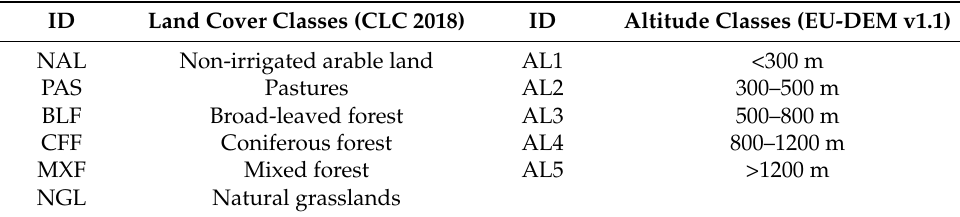
Table 2. Land cover (CLC 2018) and elevation (EU-DEM v1.1) classes and their IDs applied to the monthly NDVI-LST correlation